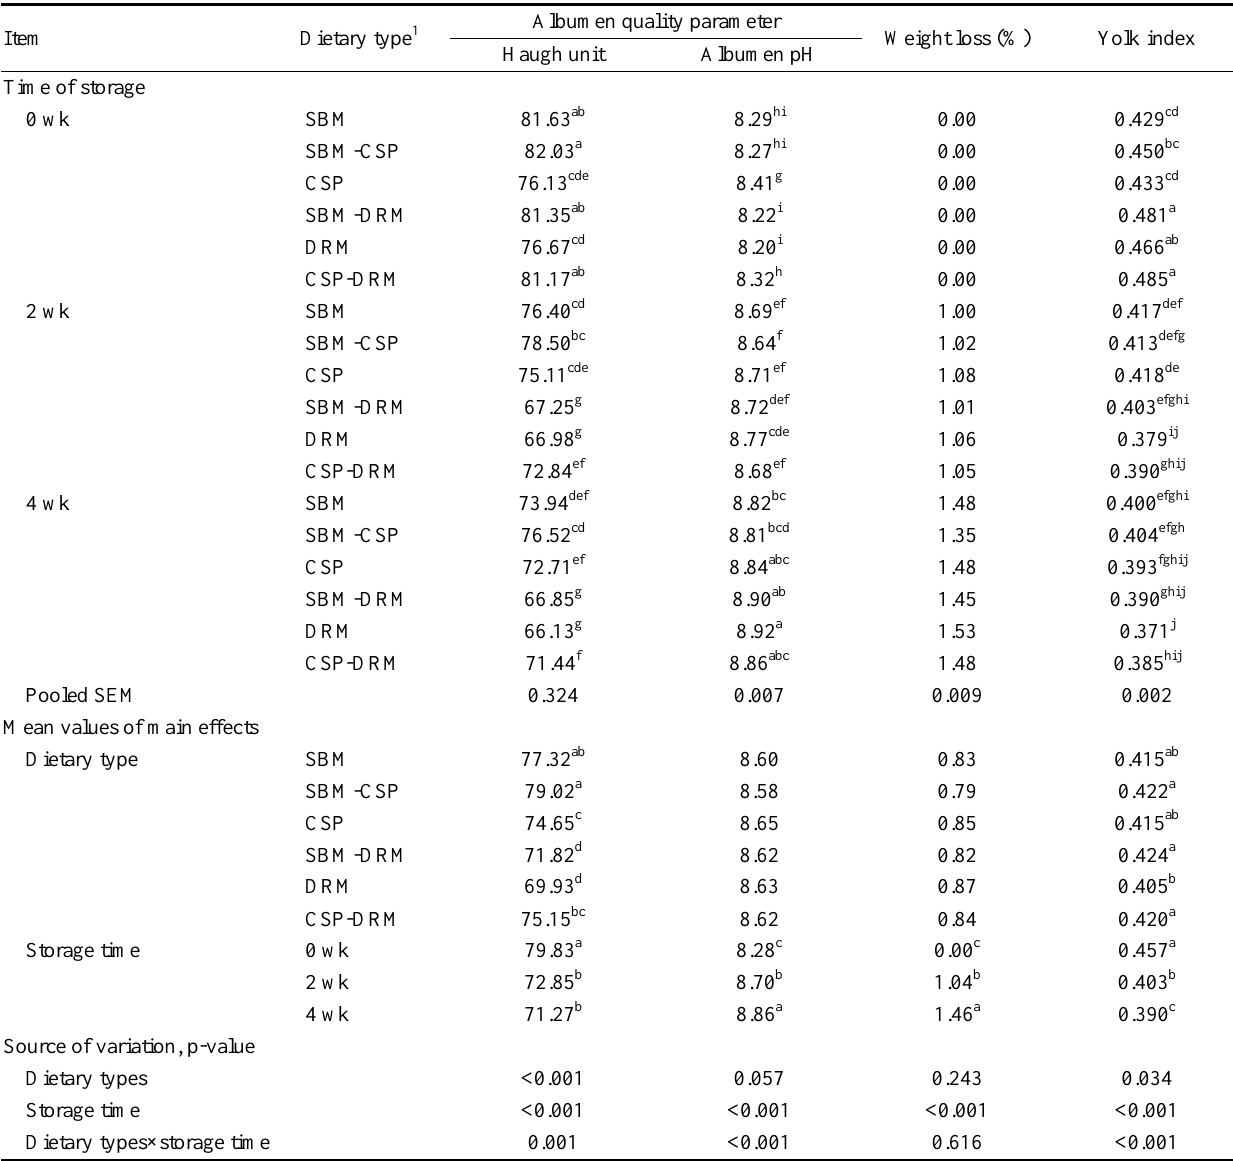
Table 3. Effect of dietary types and storage time on raw egg